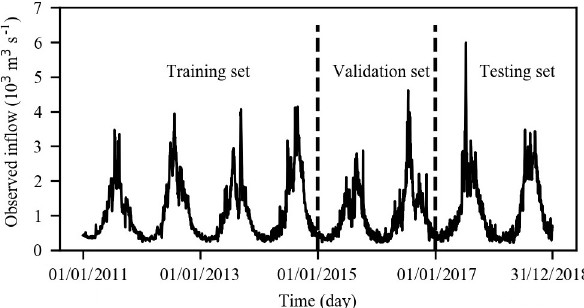
Figure 3. Daily inflow time series for the Xiaowan hydropower sta-